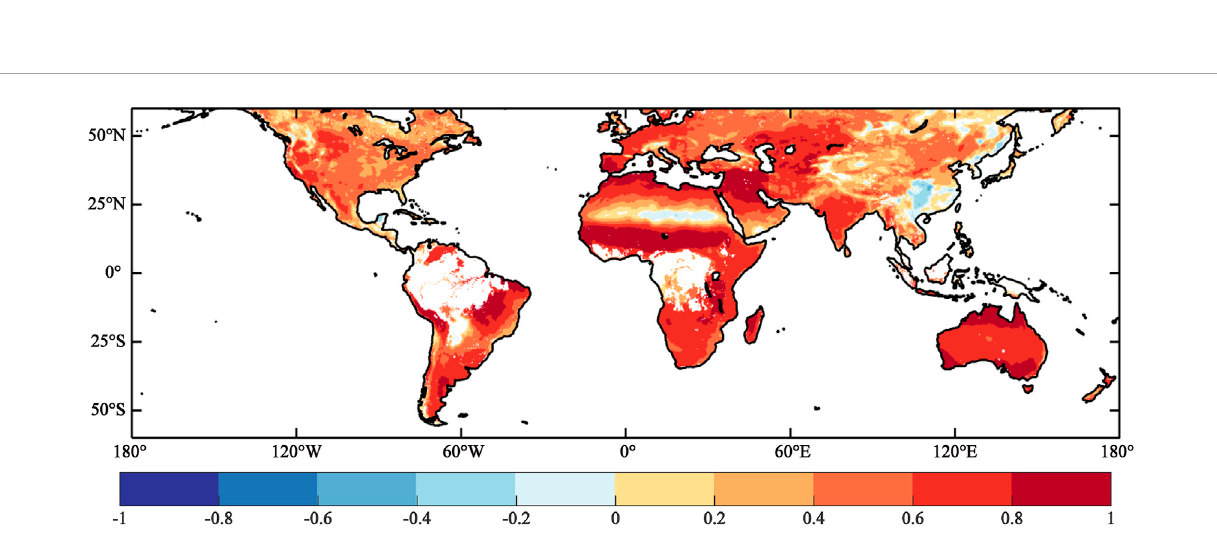
Frontiers in Earth